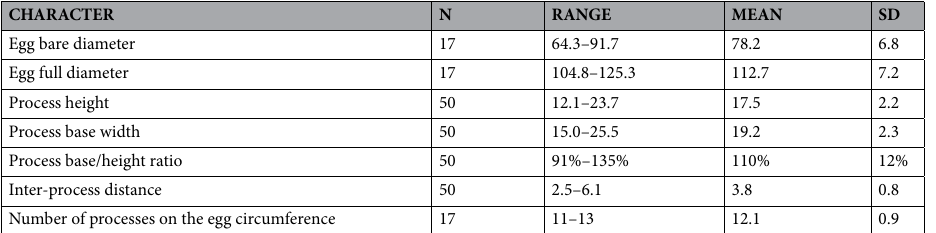
Table 3. Measurements [in µm] of selected morphological structures of eggs of Paramacrobiotus gadabouti sp. nov. mounted in Hoyer’s medium (N—number of specimens/structures measured; RANGE refers to the smallest and the largest structure among all measured eggs; SD—standard